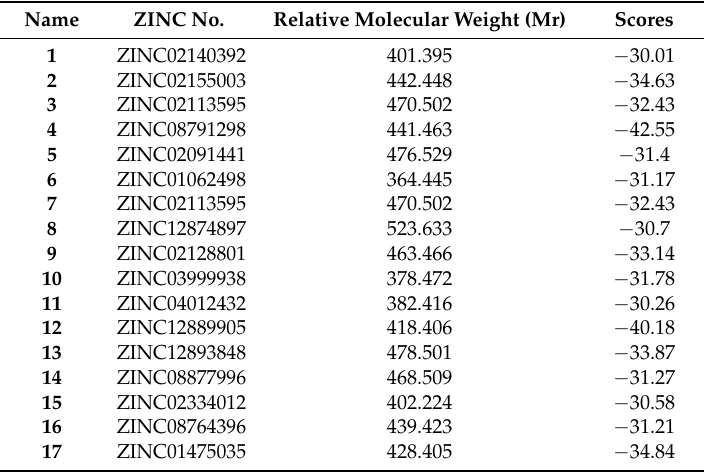
Table 1. Zinc number and docking scores of compounds used in this